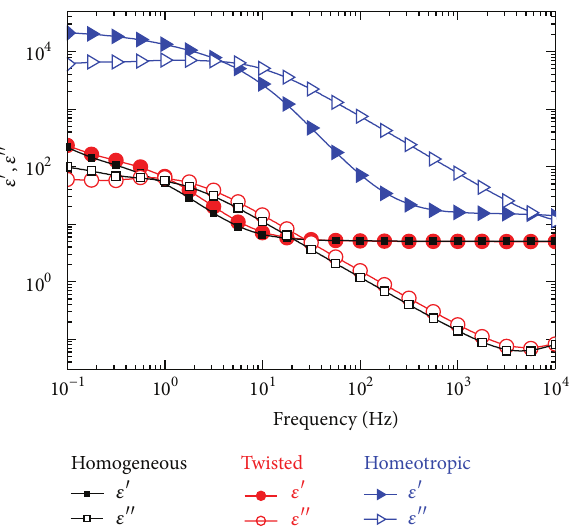
Figure 6: The dielectric spectra of E7 in homogeneous, twisted, and homeotropic cells at 296 K.